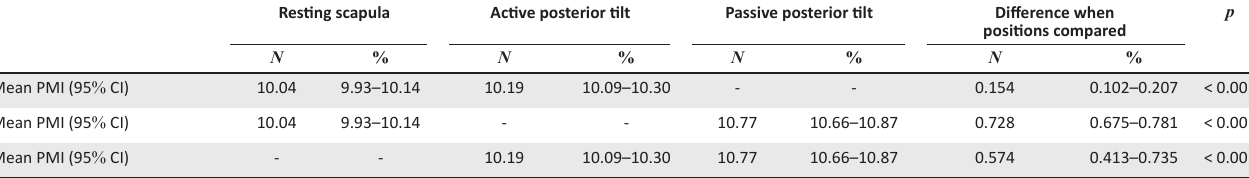
TABLE 2: The mean pectoralis minor index values (left and right) obtained and compared in the three different scapula positions ( n = 144). Resting scapula Active posterior tilt Passive posterior tilt Difference when